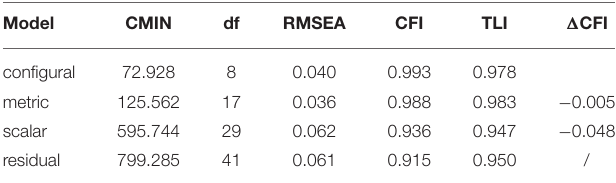
TABLE 5 | Measurement invariance of